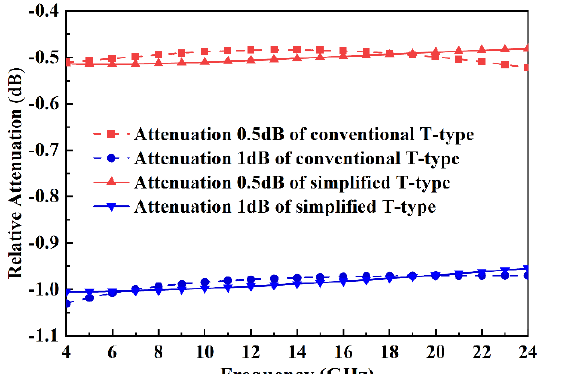
Figure 5. Comparison of the relative attenuation between the conventional and simplified T-type attenuation cell.